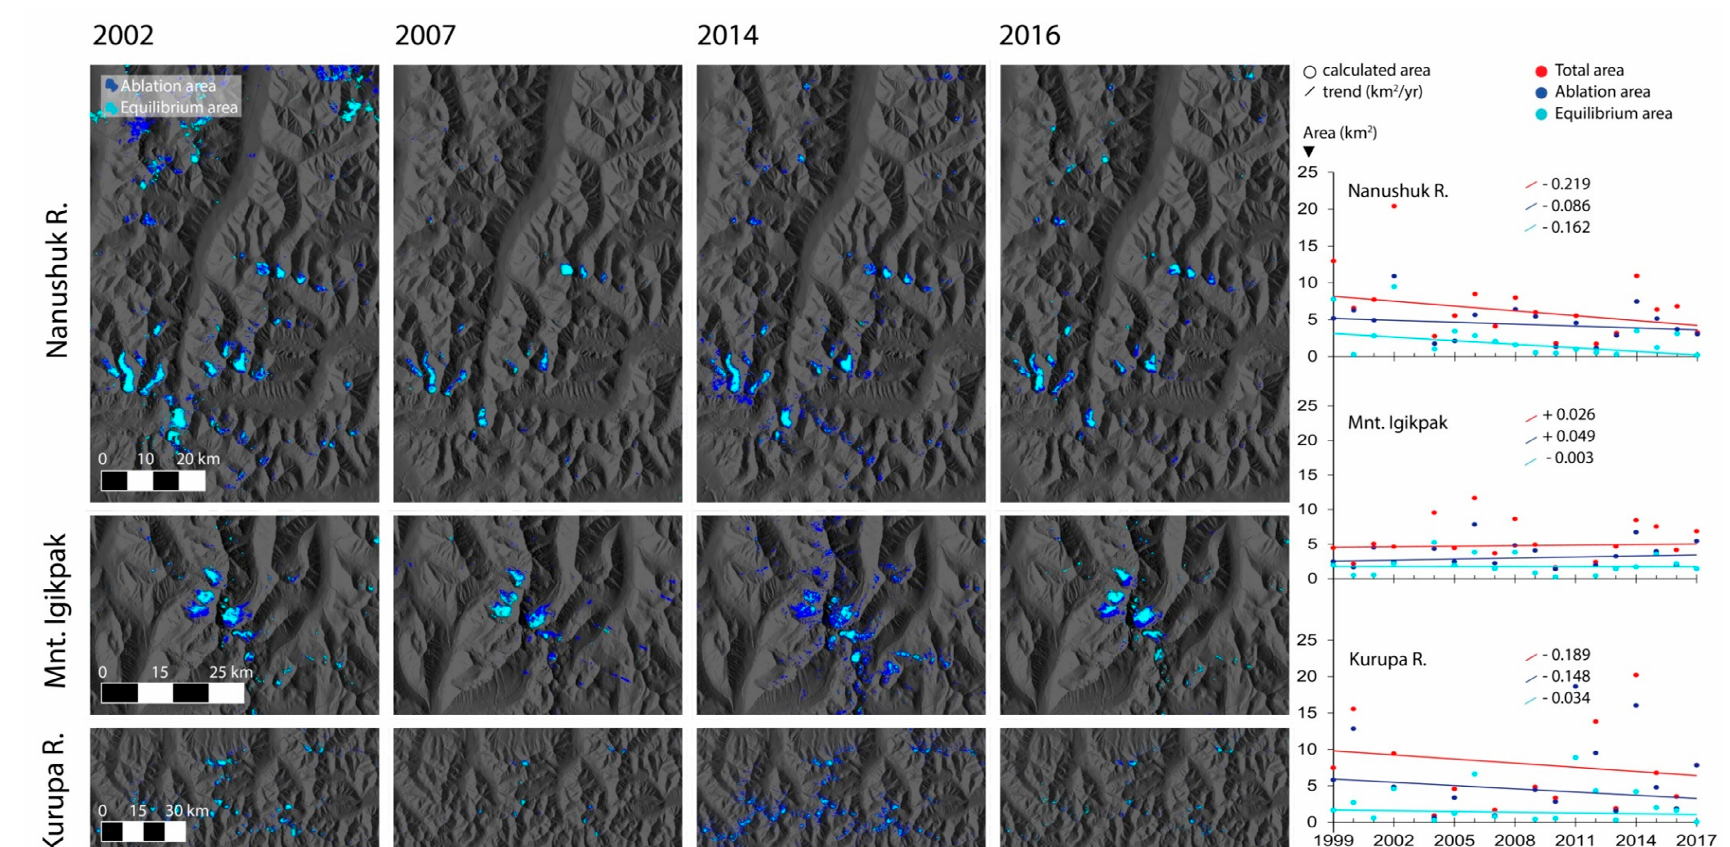
Figure 6. Annual summer season (1 July–15 Aug) perennial snowfield minimum extent time series maps derived from the 15 m scale Landsat 7 and 8 imagery (L7 / L8), showing several example years in the three localized study areas of Nanushuk River, Mount Igikpak, and Kurupa River. The maps depict changes in overall snowfield coverage, as well as changes in equilibrium areas (light blue) and in ablation areas (dark blue). The accompanying graphs show the extent changes in the three study areas quantitatively, including calculated areas for each summer from observed extent changes, as well as trends in the area changes. The trend lines are derived from the nonparametric Mann-Kendall Theil Sen’s statistical approach, for total extent changes, as well as for equilibrium and ablation area changes.